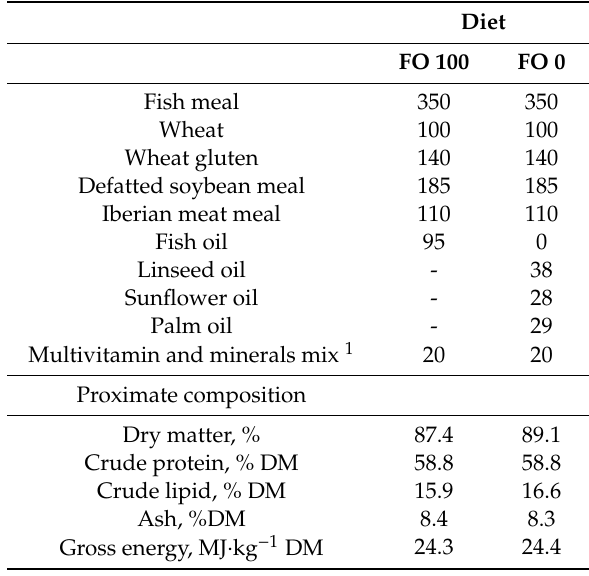
Table 6. Ingredients (g · kg − 1 as fed) and proximate composition (%dry matter) of the experimental diets.